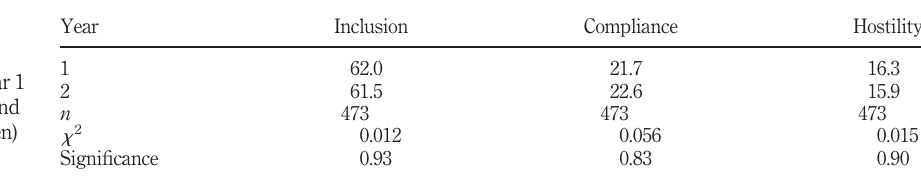
comparison, Year 1 (trans women)